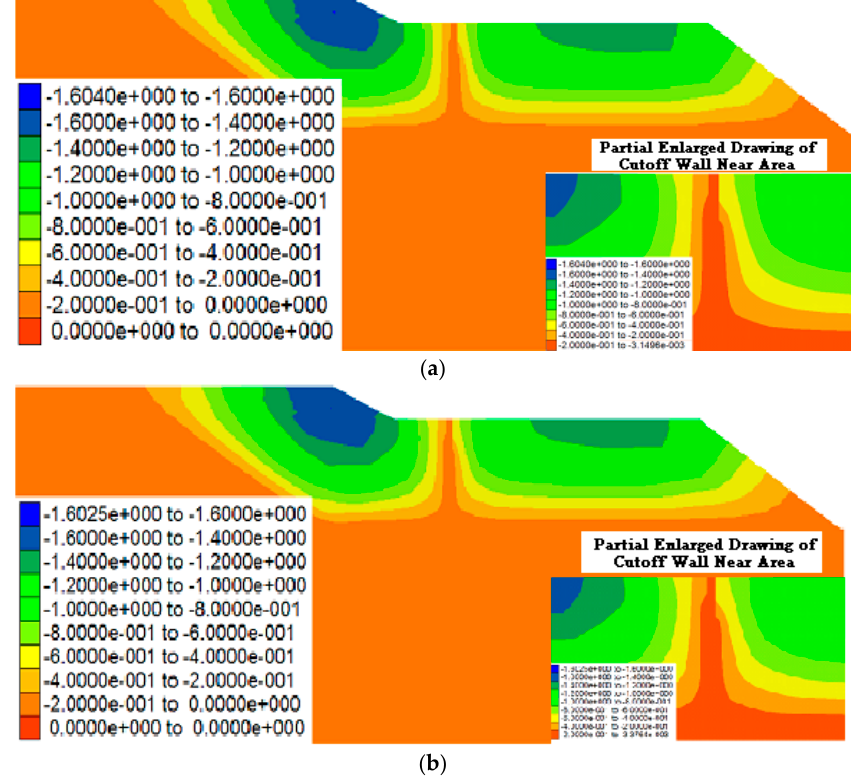
Figure 8. Cloud diagram of vertical displacement of monitoring surface. ( a ) 1. ( b ) 2.